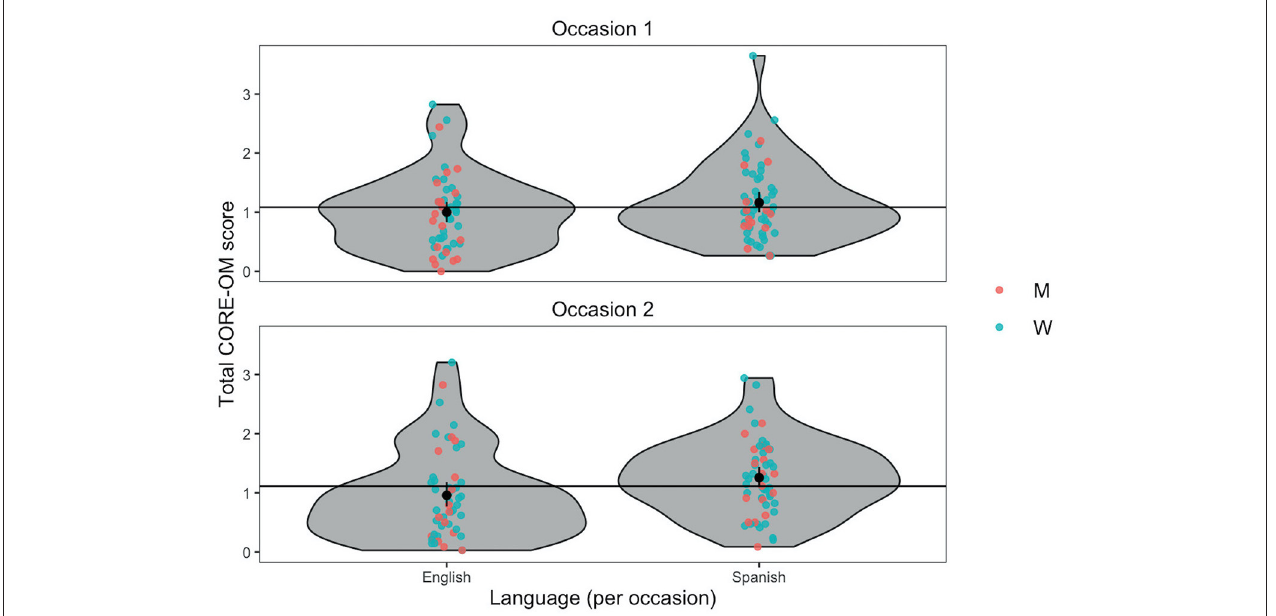
FIGURE 1 | Violin plot of CORE-OM scores by language, gender, and occasion. Jittered points show individual scores by gender, horizontal reference lines are mean scores by occasion, and black points and error bars are language means within occasion with 95% bootstrap confidence interval. Points are jittered horizontally to minimize possible overprinting but not jittered vertically so the scores are accurately represented. W, women; M, men.